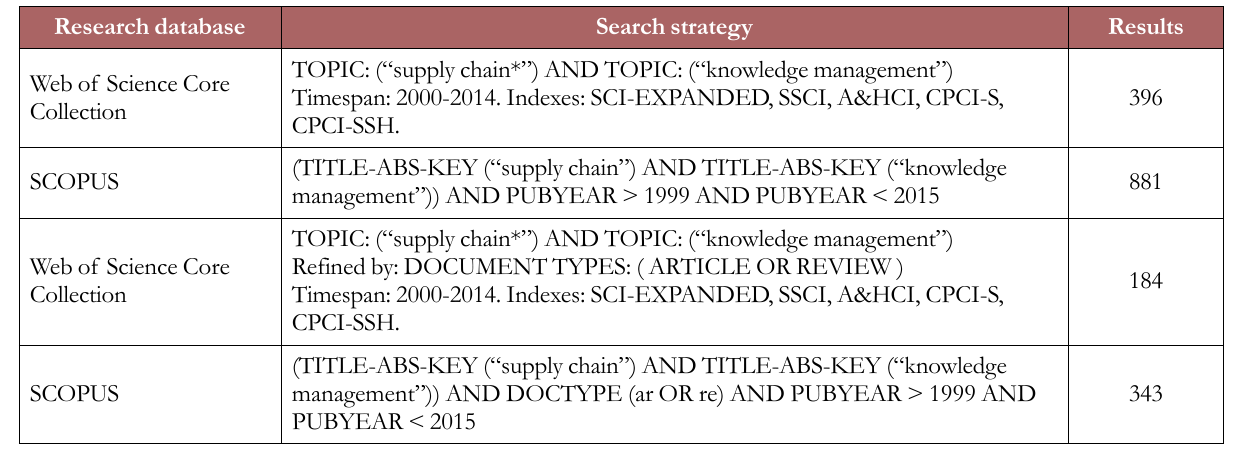
Table 2. Search criterion